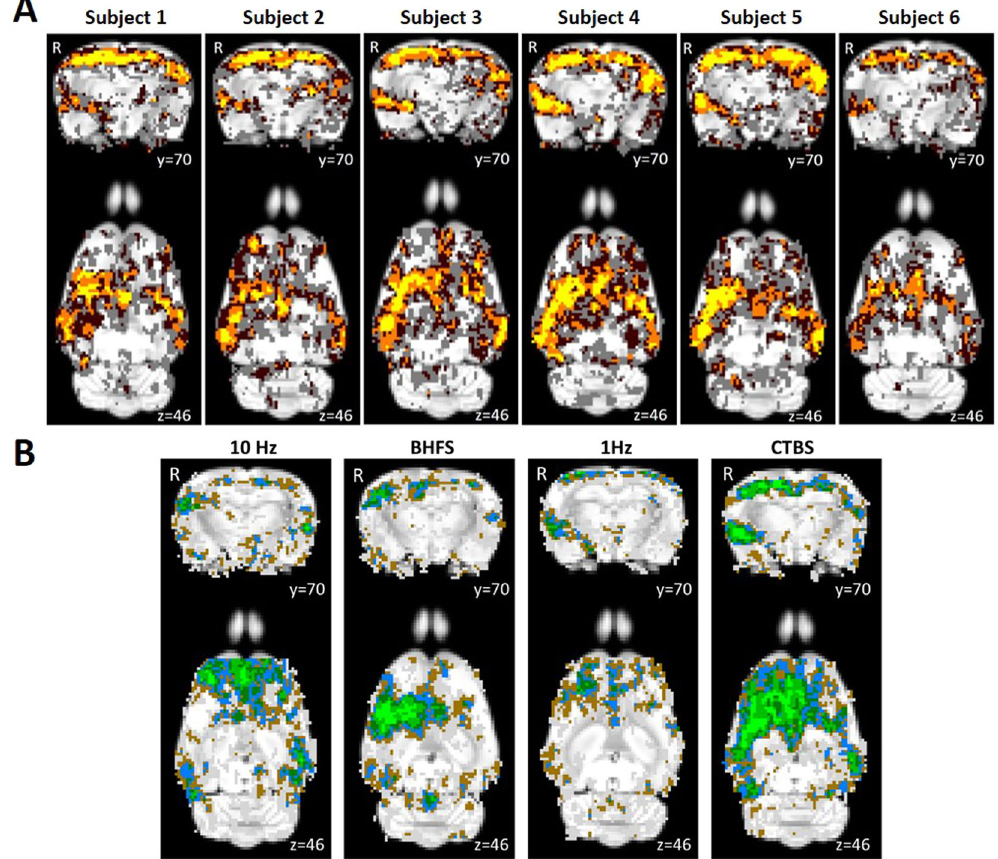
Figure 4. Reproducibility between sessions and between subjects of a representative group-ICA component. ( A ) Pre-stimulation session cumulative score maps of six subjects over the four different time points overlaid on the Sprague Dawley rat brain atlas (down-sampled by a factor of eight). x, y and z refer to the coordinates in standard Sprague Dawley template space. Colour code: voxels with z-value greater than 2 (uncorrected p-value < 0.0455 for a two-tailed hypothesis) for: one session, grey; two sessions, dark brown; three sessions, orange; four sessions, yellow. ( B ) Animal cumulative score maps of six subjects following stimulation at 10 Hz, BHFS, 1 Hz and cTBS overlaid on the Sprague Dawley rat brain atlas (down-sampled by a factor of eight). x, y and z refer to the coordinates in standard Sprague Dawley template space. Colour code: voxels with z-value greater than 2 (uncorrected p-value < 0.0455 for a two-tailed hypothesis) for: one animal, grey; two animals, brown; three animals, blue; four animals, dark green; five animals, green; six animals, bright